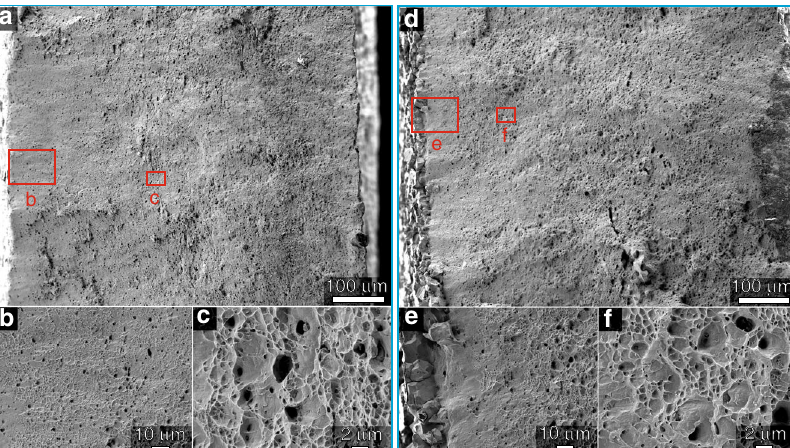
Fig. 3 Fracture surfaces of hydrogen pre-charged and uncharged equiatomic CoNiV MEA after tensile test. a Fracture morphologies of MEA samples after tensile testing without hydrogen charging, showing ductile dimple fracture surface. b , c Enlarged images for edge and interior regions of the fracture surface marked in ( a ), respectively. d Hydrogen pre-charged sample showing both brittle and ductile fracture features. e , f Enlarged images for surface and interior regions of the fracture surface marked in ( d ),